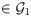
Two graphs ∈G1 maximizing and minimizing I1 and I2.